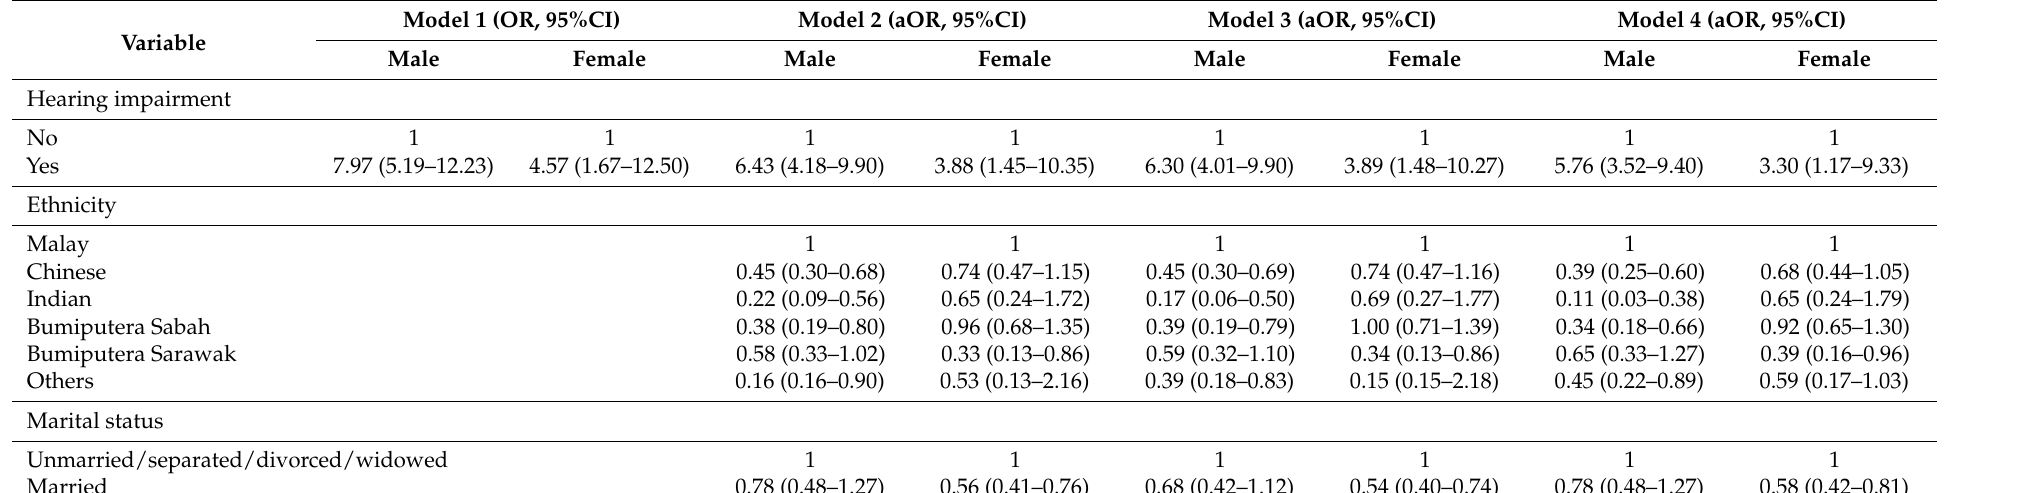
Table 3. Unadjusted and adjusted associations between hearing impairment and ADL